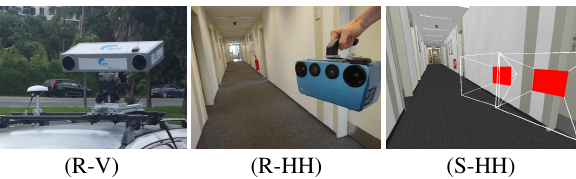
Figure 3. Used IPS sensor-heads: (R-V) Real world system on a vehicle, (R-HH) real world hand-held system, (S-HH) simulated hand-held system. (Ernst et al., 2018, Irmisch et al.,